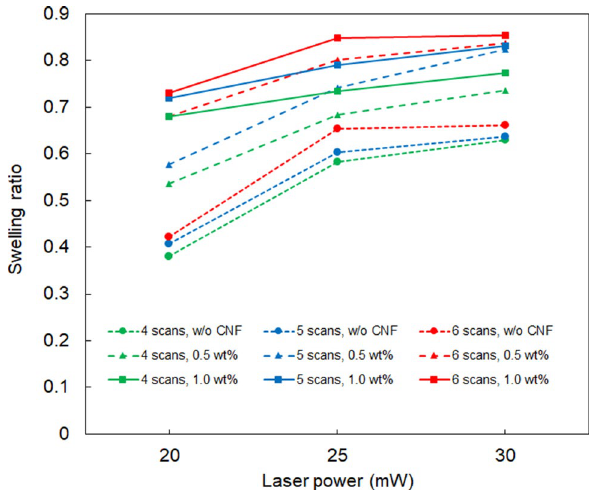
Figure 9. Swelling ratio of the microstructures fabricated at different CNF concentrations and numbers of scans. The scanning speed was 125